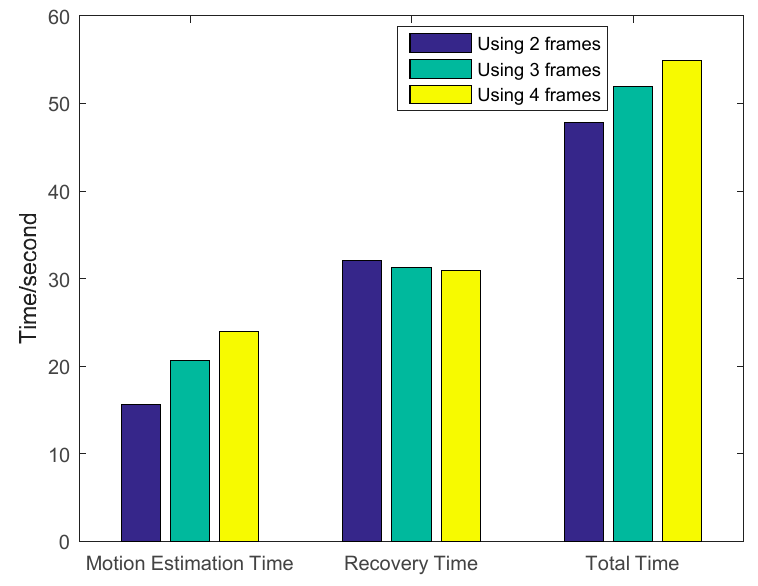
Figure 9. Time cost of the images recovered using 2, 3 and 4 frames for multi-frame motion estimation.